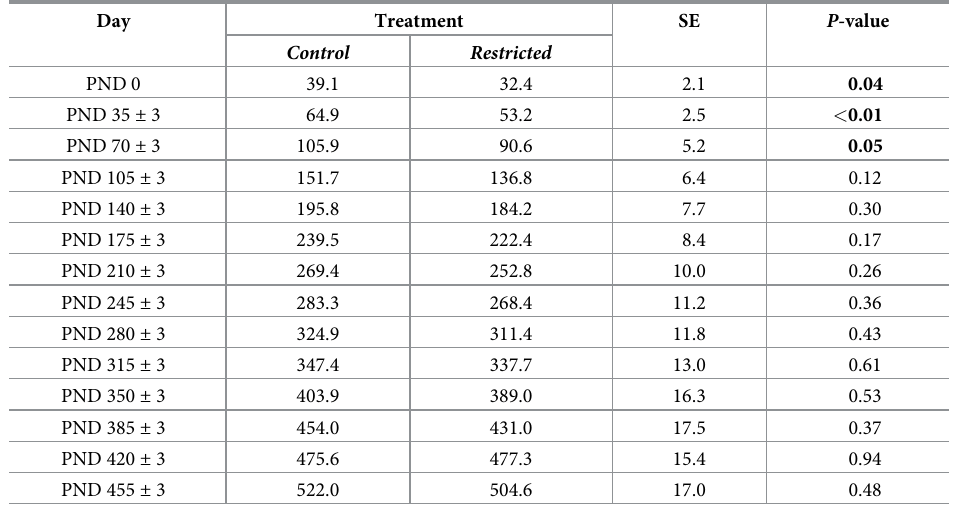
Table 2. Effects of maternal nutritional energy restriction (100% vs 70%) from GD 158 to parturition on post- natal offspring body weight (kg) in Angus cross heifers (n = 9 per treatment). Day Treatment SE P -value Control Restricted